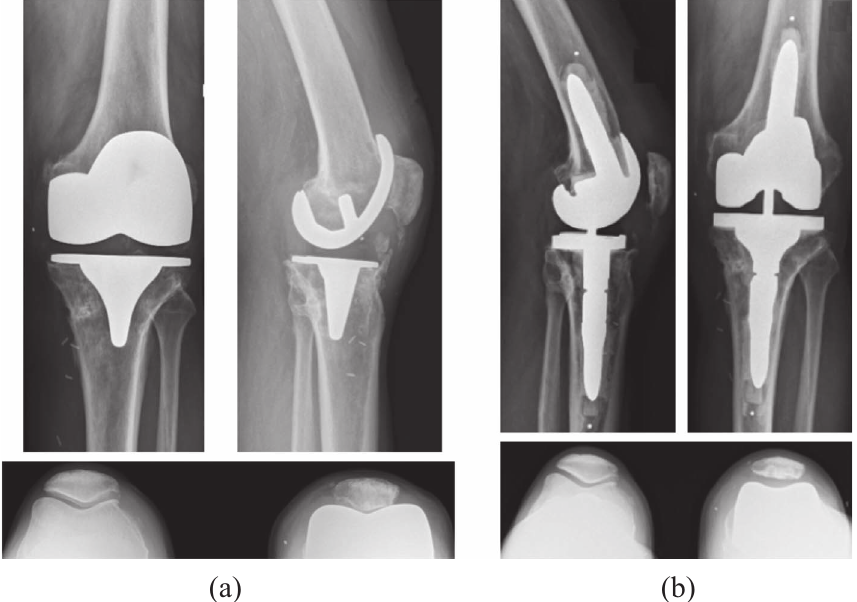
Figure 2. A 75-year-old man with painful TKA secondary to oversized femoral component (A). Revision TKA was performed with a CCK prosthesis using small cemented stems (Triathlon TS – Stryker Orthopaedics (cid:4) ) with excellent outcomes at two years follow-up